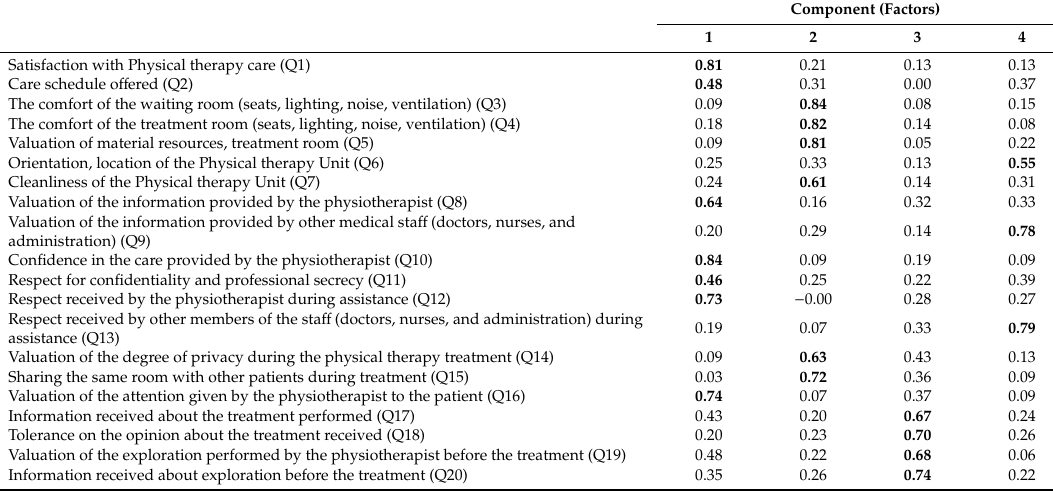
Table 2. Rotated component matrix